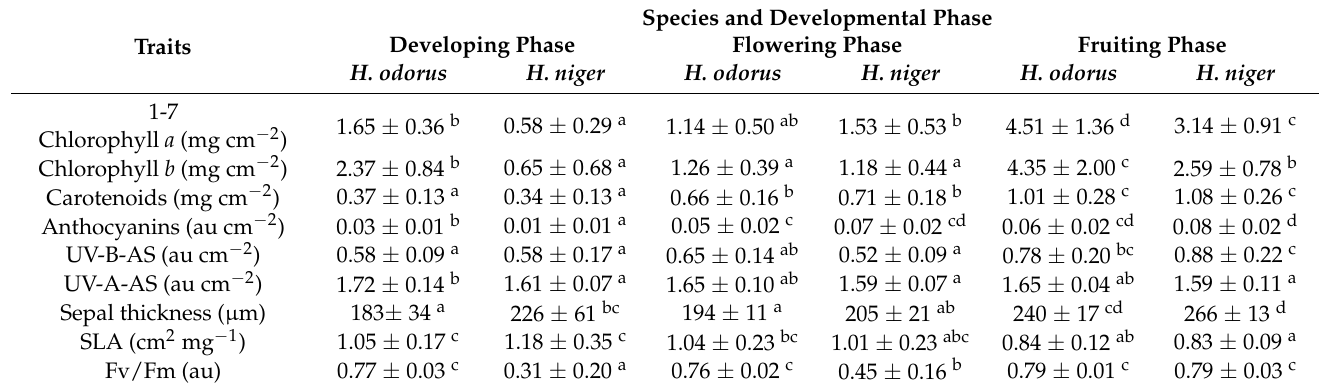
Table 1. Helleborus odorus and H. niger sepal traits for the different developmental phases.